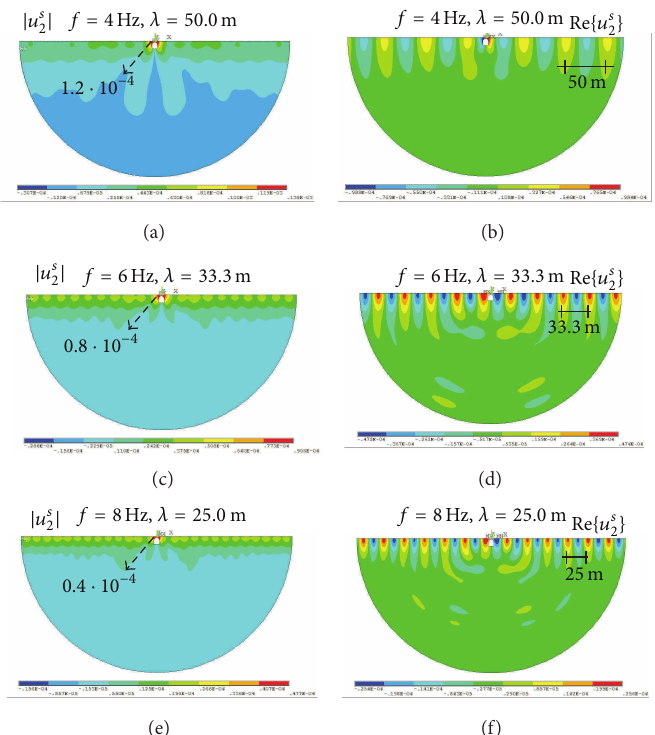
Figure 12: Absolute value |̂𝑢 𝑠 2 | ((a), (c), and (e)) and real part Re {̂𝑢 𝑠 2 } ((b), (d), and (f)) of the vertical scattered displacements, for cave 3A at different values of the frequency 𝑓 .